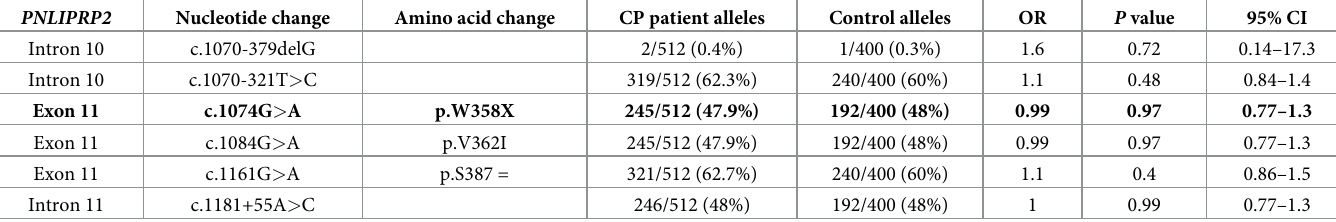
Table 4. Allele frequency of PNLIPRP2 variants in patients with chronic pancreatitis (CP) and controls without pancreatic disease.